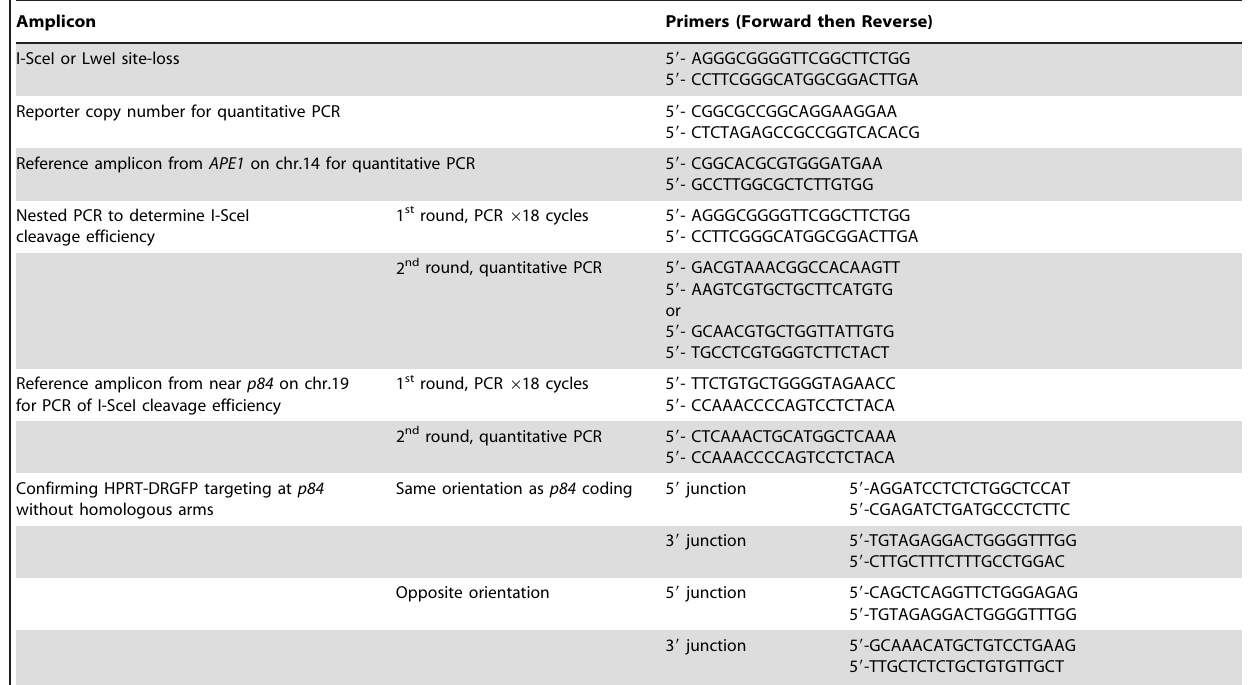
Table 1. PCR and qPCR